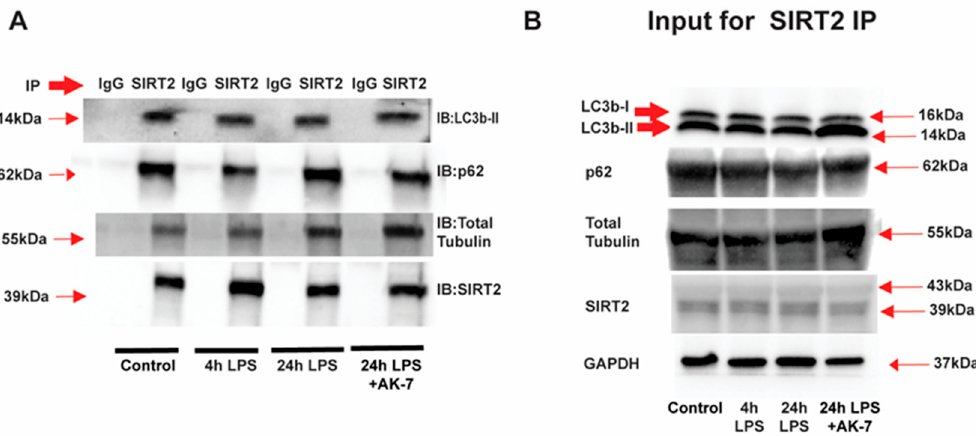
Figure 7. SIRT2 interacts with p62, LC3b and α -tubulin in sensitive and tolerant macrophages. Stearic acid (free fatty acid: FFA)-exposed sensitive and tolerant RAW264.7 cell macrophages (RAW) were stimulated with or without LPS as indicated. FFA-exposed tolerant RAW cells were treated with AK-7 or vehicle (DMSO) and stimulated with or without LPS as indicated. ( A ) SIRT2 was immunoprecipitated (IP) from whole-cell lysates of FFA-exposed sensitive and tolerant RAW cells using an anti-SIRT2 antibody followed by immunoblot (IB) analysis of the indicated proteins including LC3b-II, p62, total alpha-tubulin and SIRT2. Pull down with IgG control antibody was used as a negative control. ( B ) Western blot analysis of LC3b, p62, total alpha-tubulin and SIRT2 in the whole cell lysate used as input for the SIRT2 IP. Loading control: GAPDH.